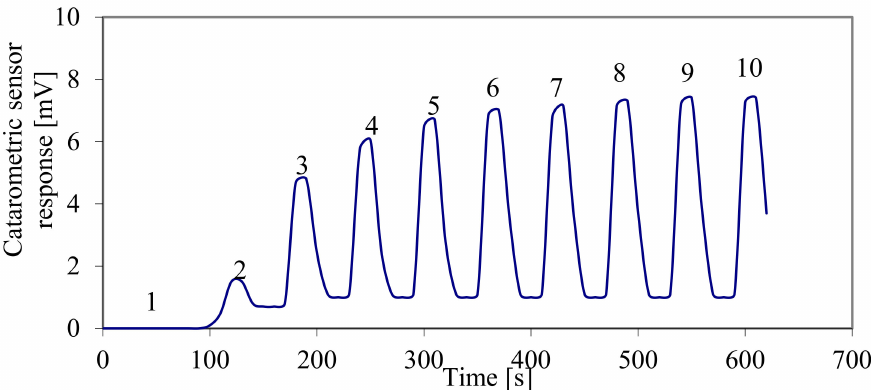
Figure 6. The process of adsorption of 10 doses of oxygen with the volume of 109 mm 3 in a stream of helium on the tested IIAg/Al 2 O 3 -SiO 2 catalytic converter sample. Oxygen concentrations downstream of the sample were proportional to the voltage signal of the thermal conductivity detector.